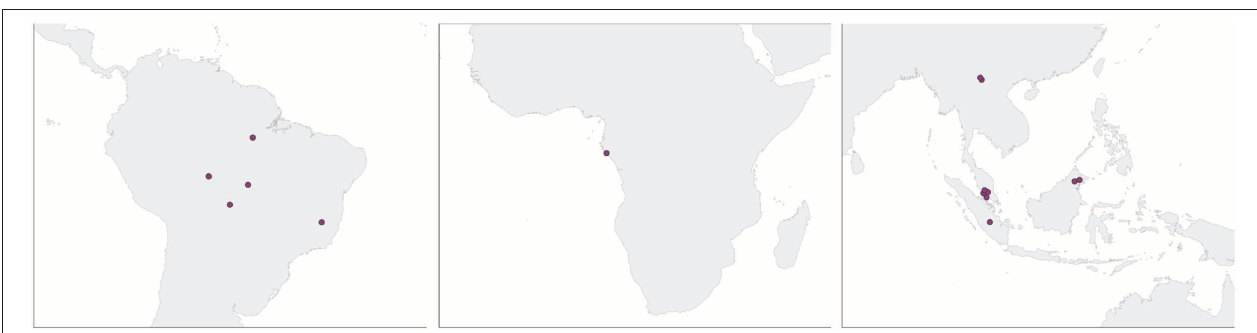
FIGURE 2 | Study locations from the Amazon, Congo, and SE Asia. Studies from the same site are represented by a single dot.